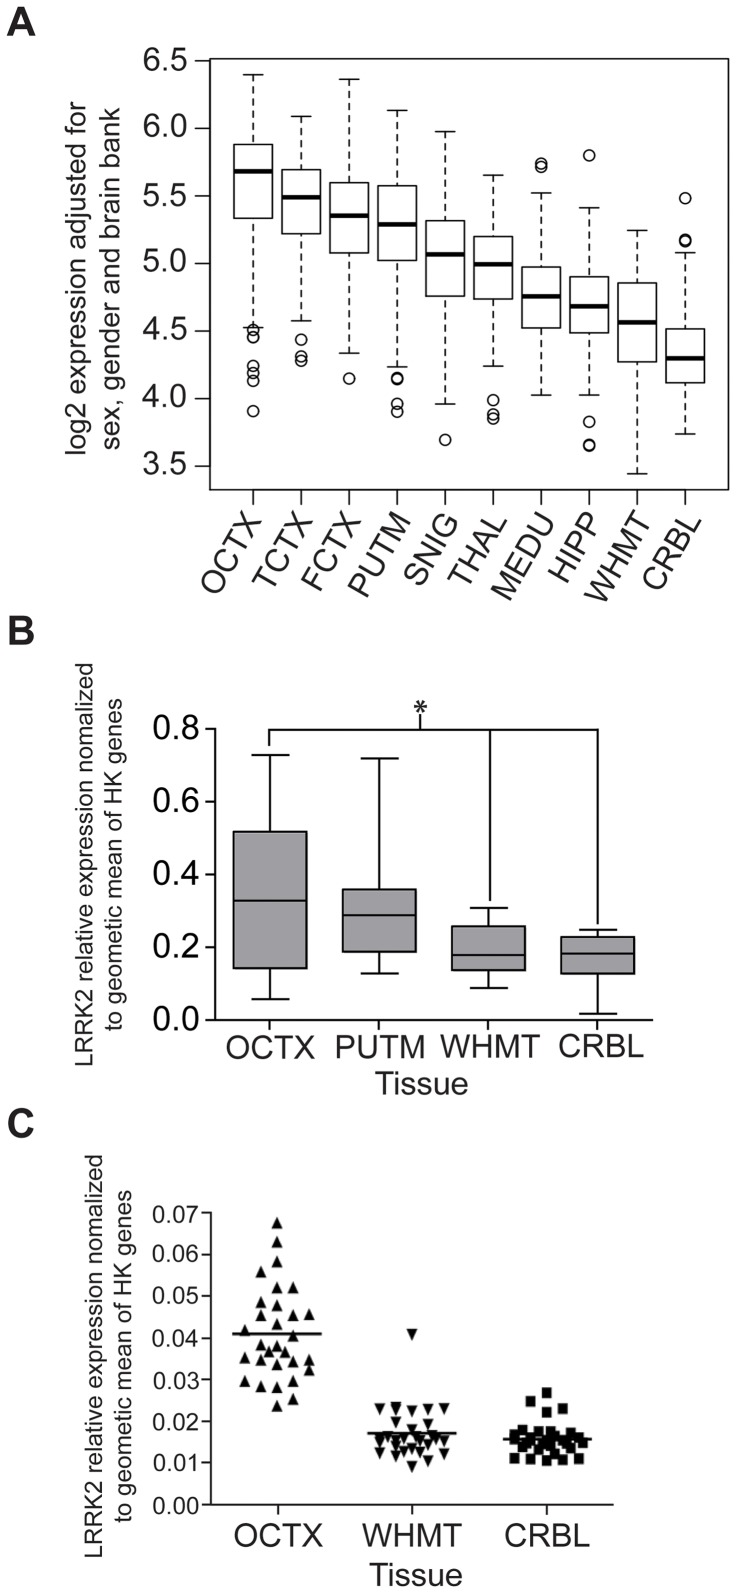
Regional variability in LRRK2 expression.(A) Box plot of mRNA expression levels for LRRK2 in 10 brain regions, based on microarray experiments and plotted on a log2 scale (y axis). Whiskers extend from the box to 1.5 times the inter-quartile range. (B) Box plot of mRNA expression levels for LRRK2 in 4 brain regions, based on QuantiGene experiments. Whiskers extend to the maximum and minimum values. Stars indicate significant differences in expression between brain regions (p-value <0.01, Wilcoxon signed rank testing). (C) Dot plot of mRNA expression levels for LRRK2 in 3 brain regions based on TaqMan Real Time PCR experiments. The expression levels were normalized to the geometric mean of 3 housekeeping genes. The graph shows higher expression in OCTX compared with other regions. Abbreviations: frontal cortex (FCTX), occipital cortex (specifically primary visual cortex, OCTX), temporal cortex (TCTX), intralobular white matter (WHMT), thalamus (THAL), putamen (PUTM), substantia nigra (SNIG), hippocampus (HIPP), medulla (specifically inferior olivary nucleus, MEDU) and cerebellum (CRBL).